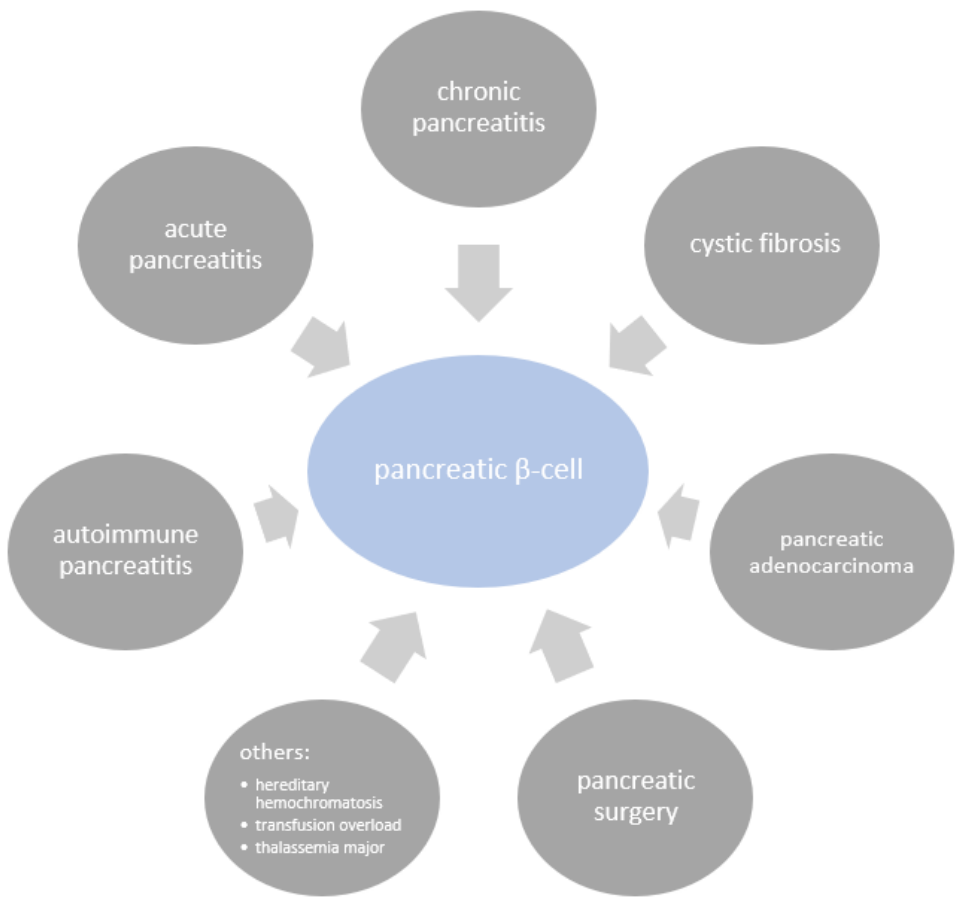
Figure 1. The most common pancreatic exocrine diseases responsible for